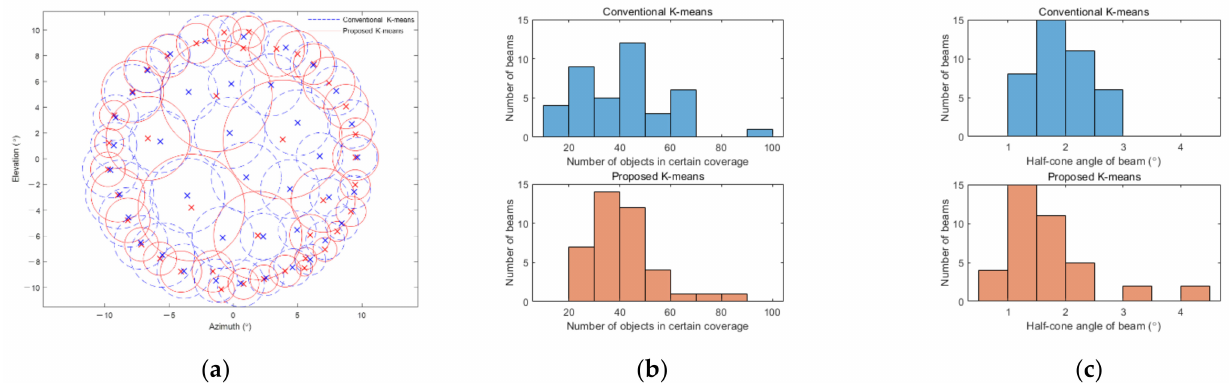
Figure 6. The primary results of the beam allocation of objects in Figure 5 following the conventional K-means and proposed K-means, respectively: ( a ) Plot of the allocated 40 beams. The crossing indicates the geometrical center of each beam. The blue dash circles indicate the clusters of conventional K-means; the red circles are the results of the proposed K-means; ( b ) Statistics of the beam occupation; ( c ) Statistics of the beam